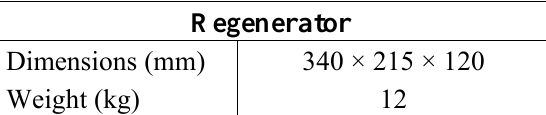
Table 5. Regenerator device.